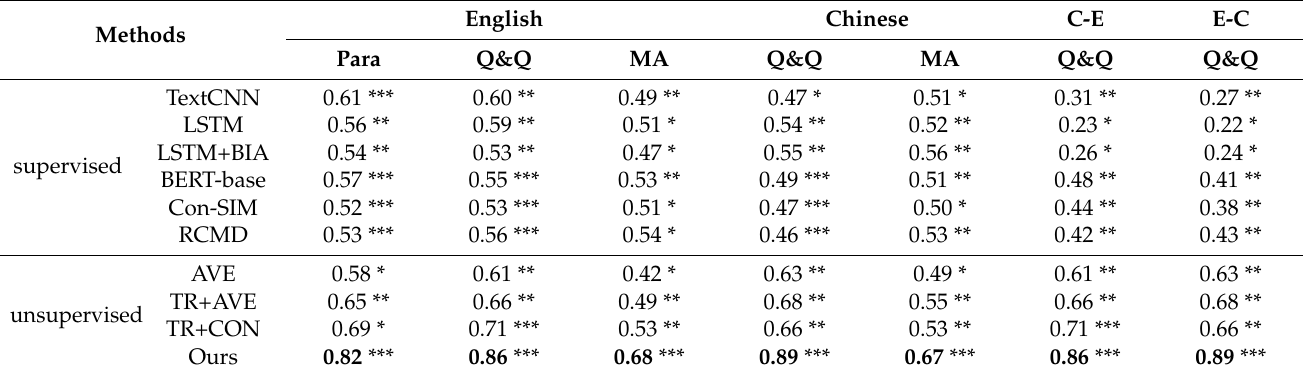
Table 6. The results of all the algorithms in the transferring scenario (highest values in bold. ***, **, and * indicate three significant levels as 0.01, 0.05, and